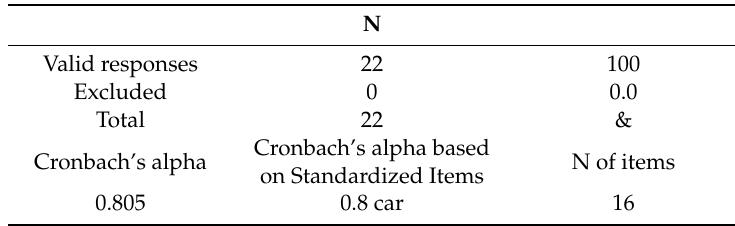
Table 1. Cronbach’s